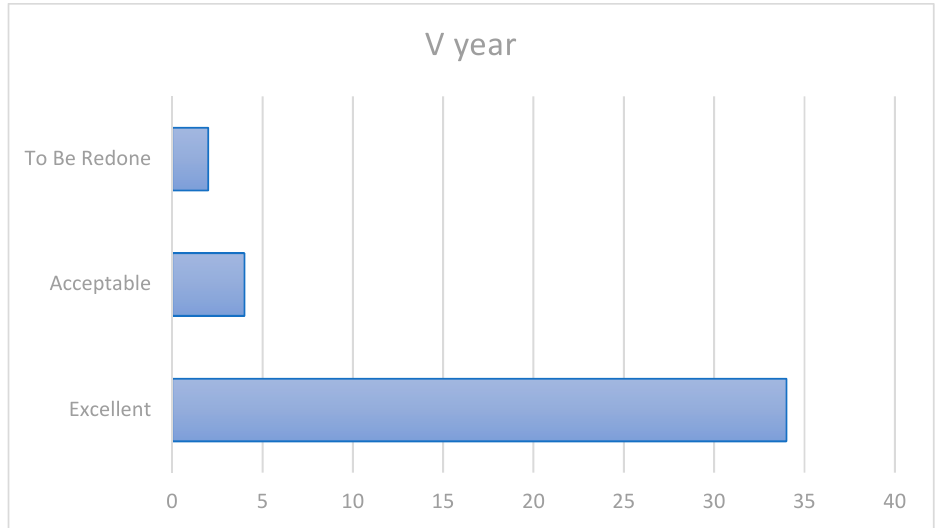
Figure 4. Fifth-year outcomes.